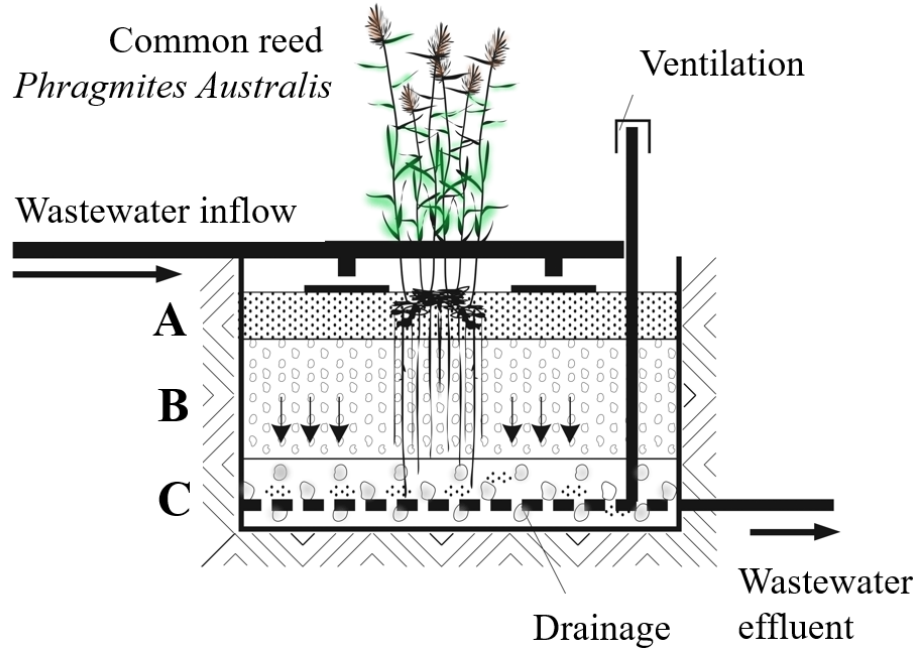
Table 1. Characteristics of the bed filling.